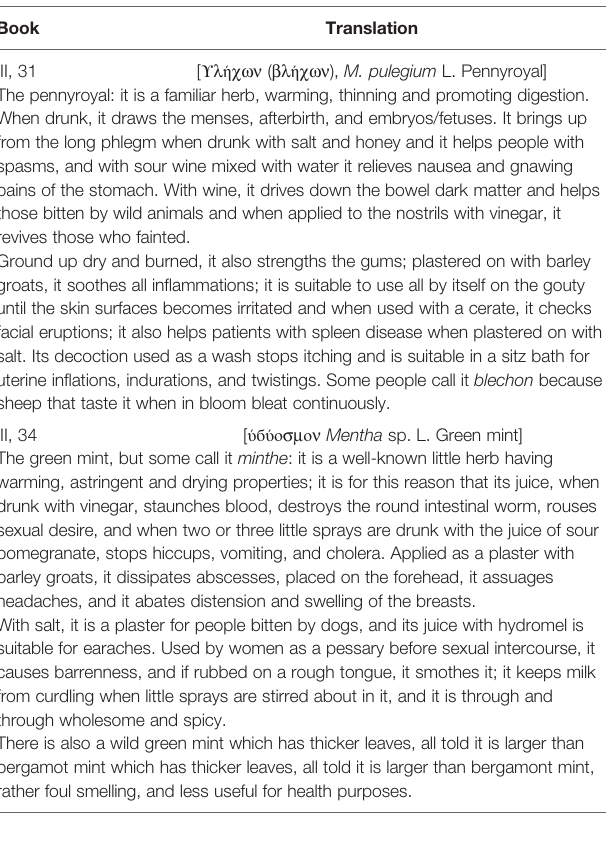
TABLE 1 | English translation of reference to species of Mentha in De Materia Medica of Dioscorides (Beck, 2005). Book Translation